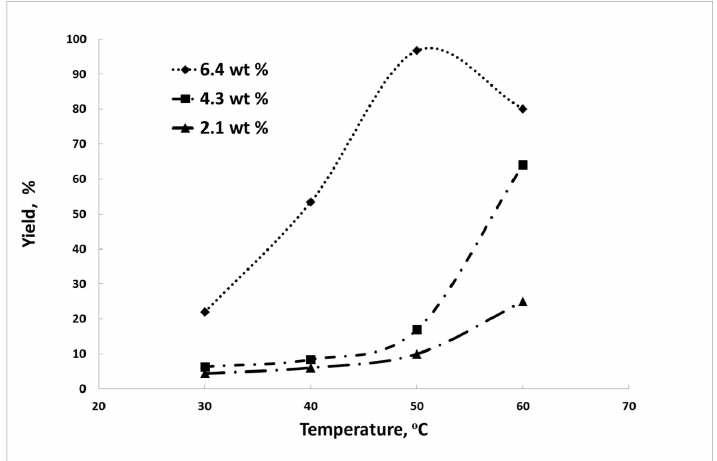
Figure 5. The effect of temperature on biodiesel yield at the MeOH/WVO molar ratio of 11.5:1 in the presence of 2.1, 4.3 and 6.4 wt % TZT catalyst, at temperatures of 30, 40, 50 and 60 ◦